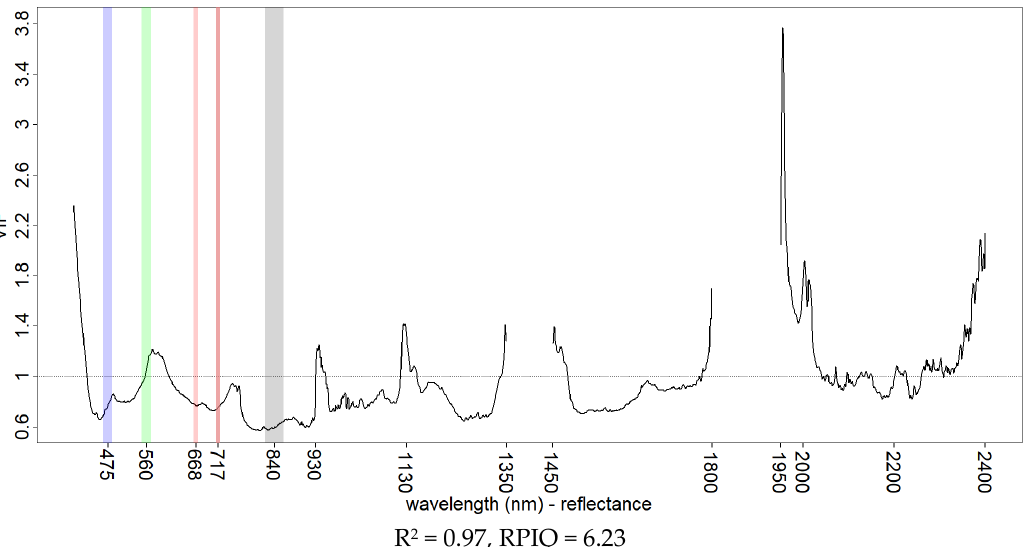
Figure 10. VIP scores of KE PLSR models from hyperspectral data using full vis-NIR-SWIR reflectance spectral range. Goodness of fit is reported using R 2 and RPIQ. The multispectral broad-bands of the Rededge-M camera model are shown for comparison.